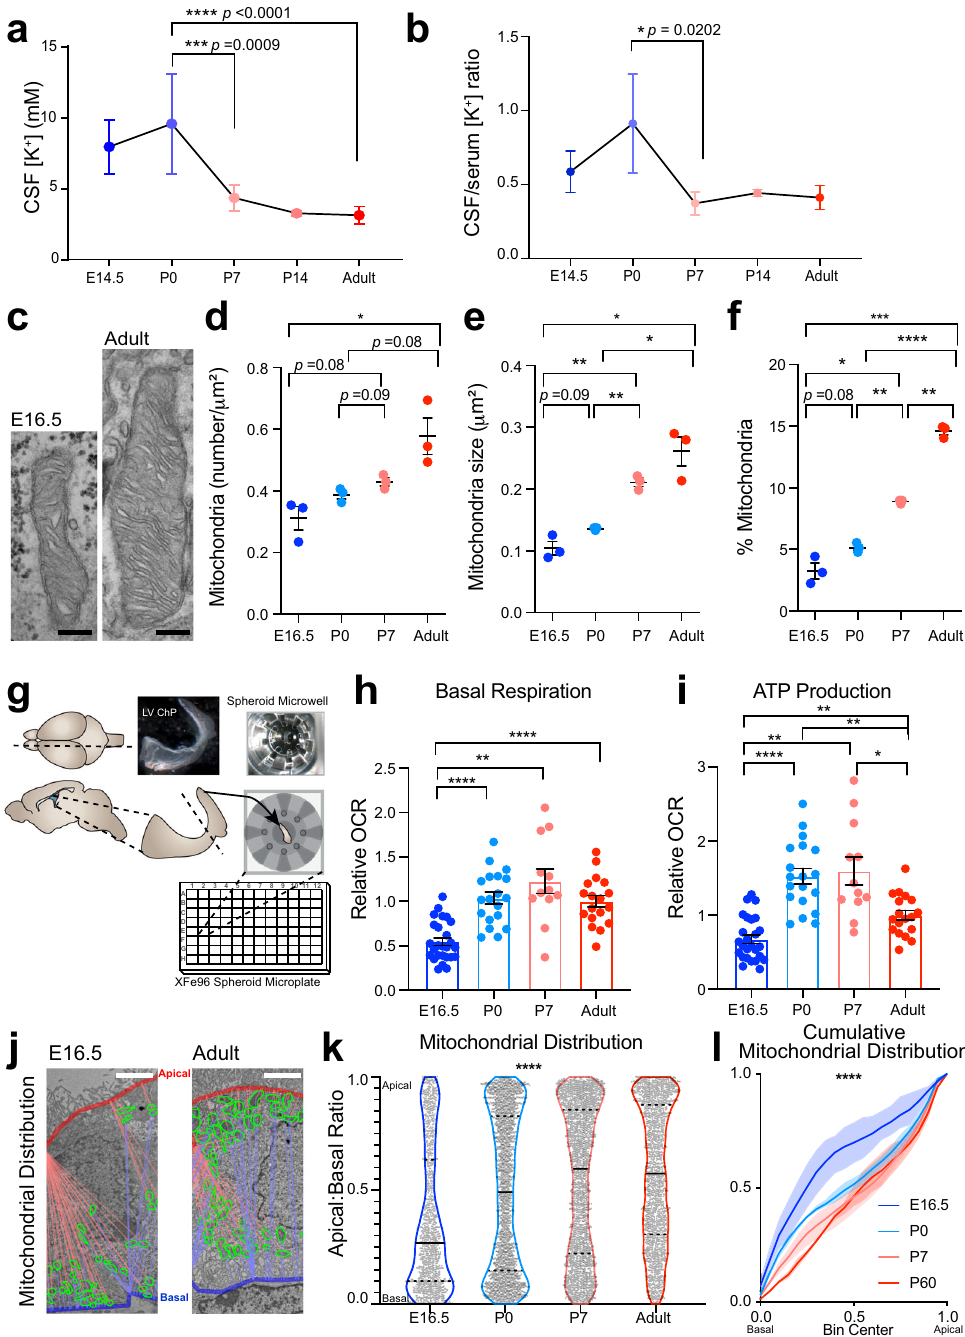
Fig. 1 Postnatal CSF [K + ] decrease coincides with increased choroid plexus metabolism. a ICP-OES quanti fi cation of CSF [K + ]. Colors: blue-to-red indicate increasing age in all panels. *** p = 0.0009, **** p < 0.0001; Sidak ’ s test. b Developmental CSF/Serum [K + ] ratios. Ratio = CSF [K + ]/average serum [K + ]; Sidak ’ s test. * p = 0.0202. c Transmission micrographs of LVChP mitochondria. d – f Quanti fi cation of mitochondrial number ( d ), area ( e ),